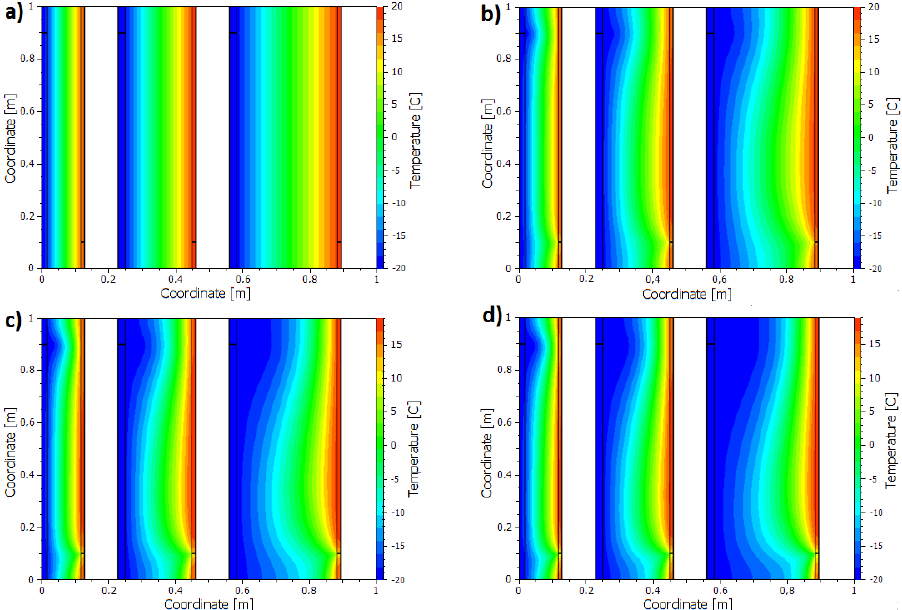
Figure 15. The temperature distribution in the 110 kg/m 3 models: no filtration ( a ), 5 Pa pressure difference ( b ), 10 Pa pressure difference ( c ) and 15 Pa pressure difference ( d ).